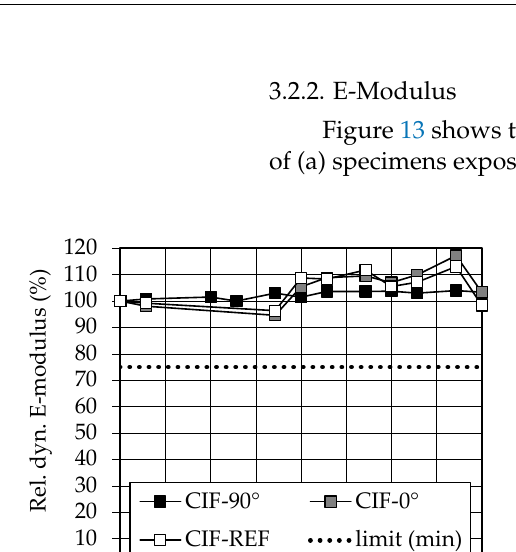
Figure 12. Water adsorption of ( a ) CIF specimens and ( b ) CDF specimens.